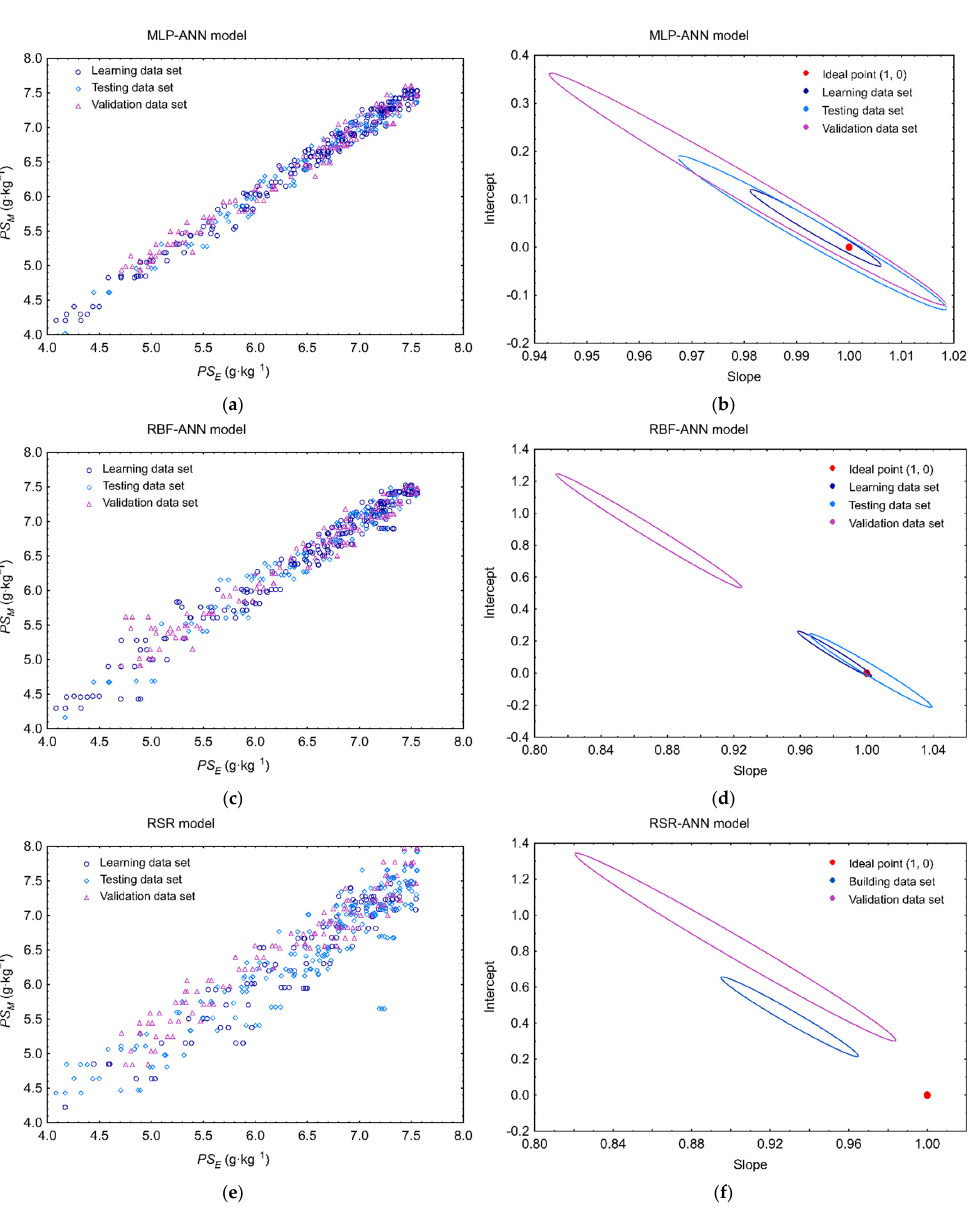
Figure 4. Predictability of ( a ) MLP-ANN ( c ) RBF-ANN and ( e ) RSR model of phytosterol degradation in a stored bulk of rapeseed ( PS M ) in relation to the experimental values of phytosterol content ( PS E ) adopted from Wawrzyniak et al. [7], together with elliptical joint confidence regions at a 95% level for the slope and intercept of the regression of predicted PS M versus experimental PS E using ordinary least squares, respectively, for ( b ) MLP-ANN, ( d ) RBF-ANN, and ( f ) RSR model.